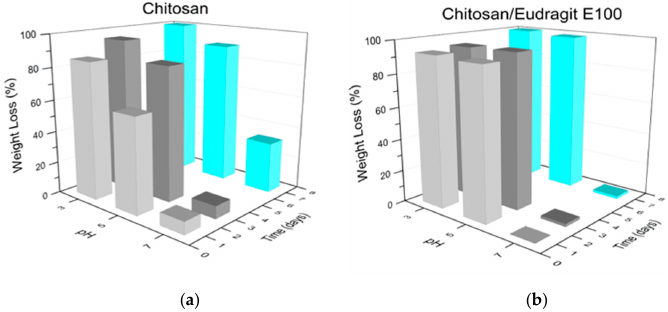
Figure 7. Results of the weight loss (WL) analysis of the ( a ) chitosan and ( b ) chit / EE100 coating (A1 sample).